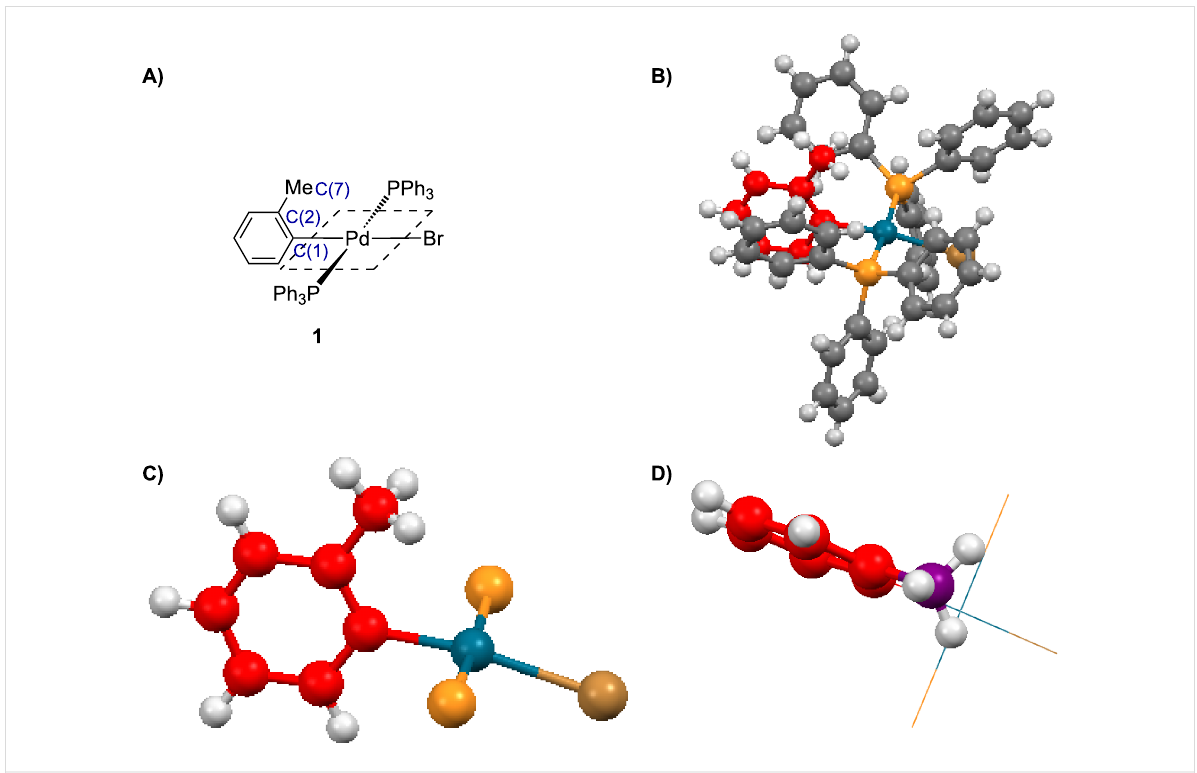
Figure 2: A) molecular structure of complex 1 ; B) ball and stick representation of X-ray structure; C) ball and stick representation of X-ray structure showing the tolyl group only; D) topside view of X-ray structure [18].